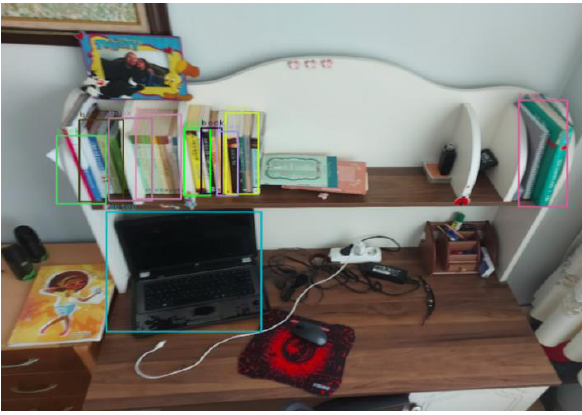
Fig. 16. Objects recognized using YOLOv3 architecture on the study table.